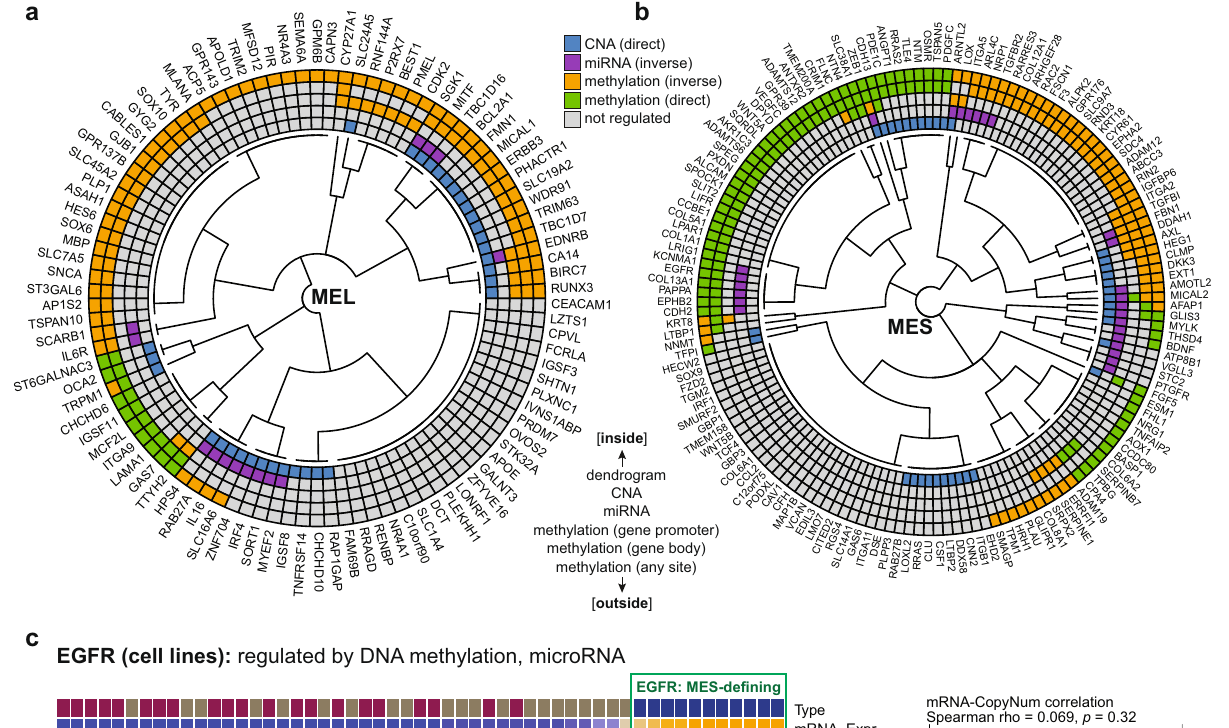
EGFR (cell lines): regulated by DNA methylation, microRNA